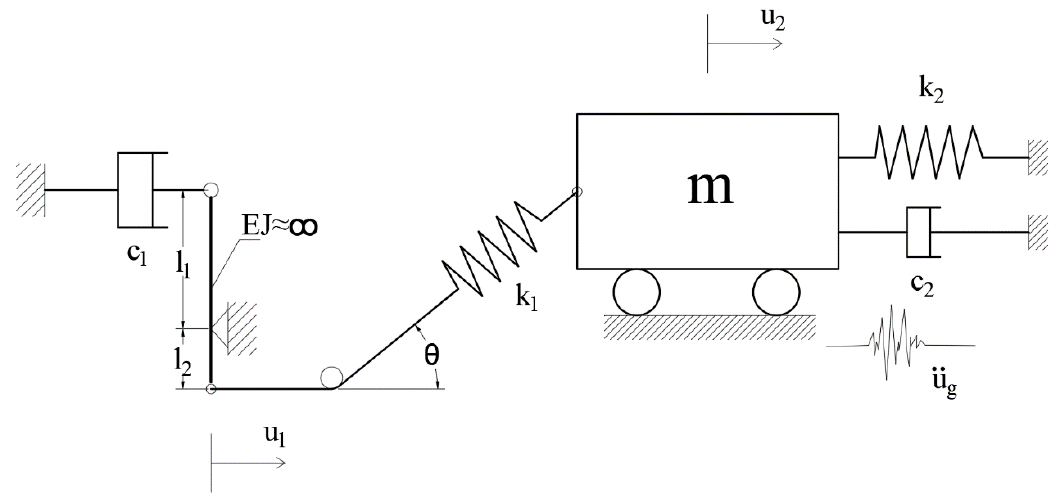
Figure 2. Mechanical model of a two degrees of freedom (2-DOF) structure equipped with the proposed system.